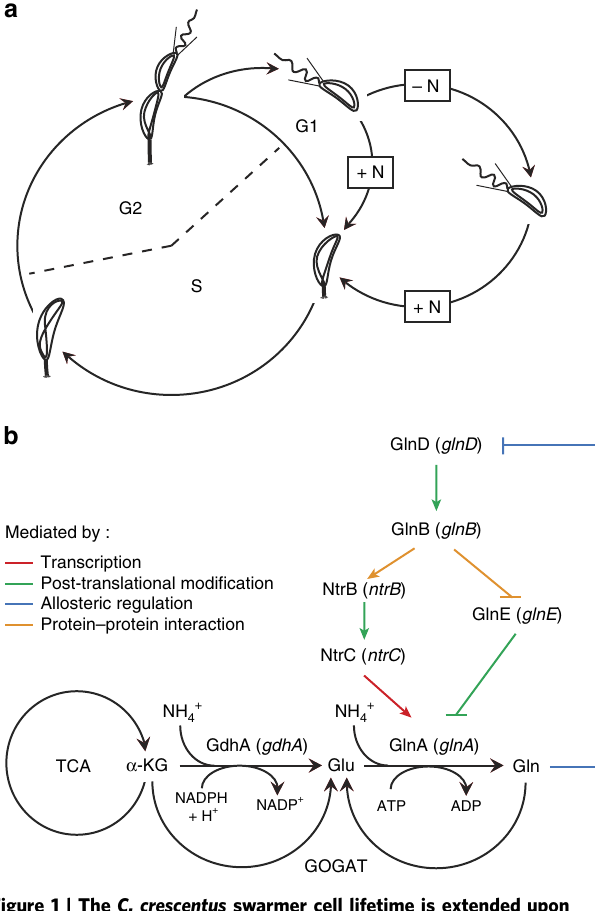
Figure 1 | The C. crescentus swarmer cell lifetime is extended upon nitrogen starvation. ( a ) Asymmetric cell division of C. crescentus gives birth to a non-replicative swarmer cell that goes through G1 phase before replicating and a replicative stalked cell that directly enters into S phase. Upon nitrogen starvation ( (cid:2) N), swarmer cells extend their G1 phase. ( b ) In E. coli , ammonium can be assimilated either by the NADP-dependent glutamate dehydrogenase (GdhA) to generate glutamate (Glu) from a -ketoglutarate ( a -KG) or by the glutamine synthetase (GlnA) to produce glutamine (Gln) from Glu, this latter being recycled by the glutamate synthase (GOGAT). GlnA is regulated at different levels by the GlnD/GlnB/ GlnE and NtrBC pathways, and GlnD senses intracellular pool of